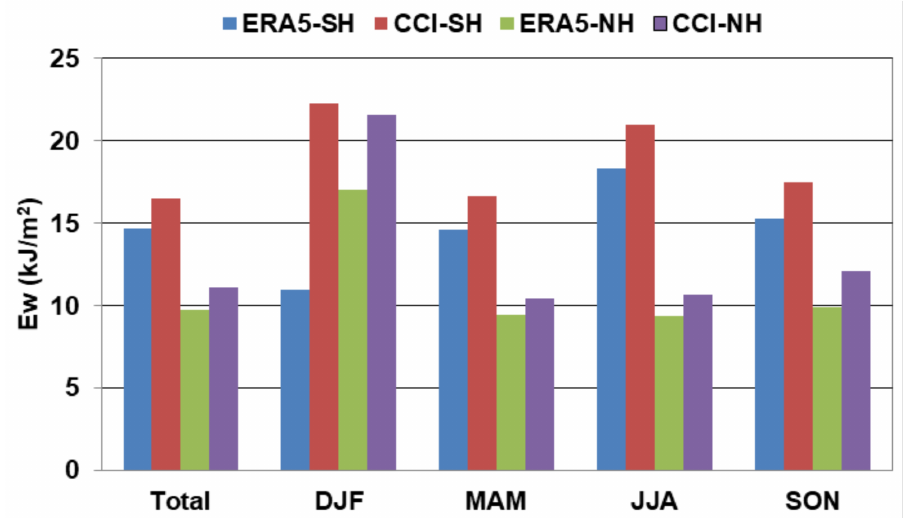
Figure 8. Maximum values of the mean E w-CCI and E w-ERA5 in the Southern and Northern Hemi- spheres, 27-year time interval (1992–2018), for total data and each season considered. The comparison shows that higher E w values were estimated based on CCI-SS data; to find the magnitude of these differences, the normalized differences (%) between